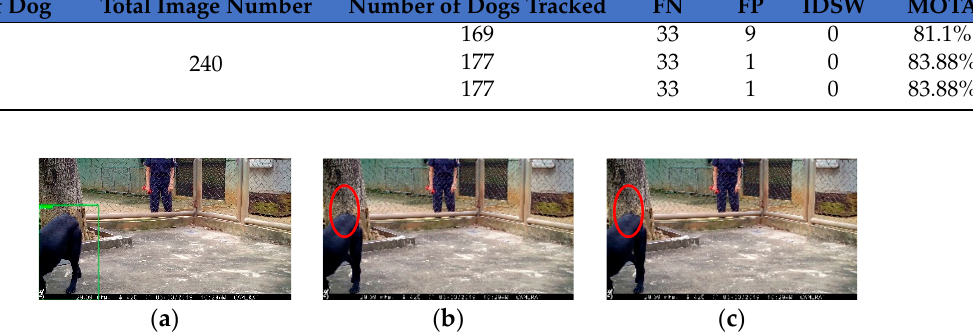
Figure 15. Dog not tracked in images 211 and 212. ( a ) Image 210; ( b ) Image 211; ( c ) Image 212.